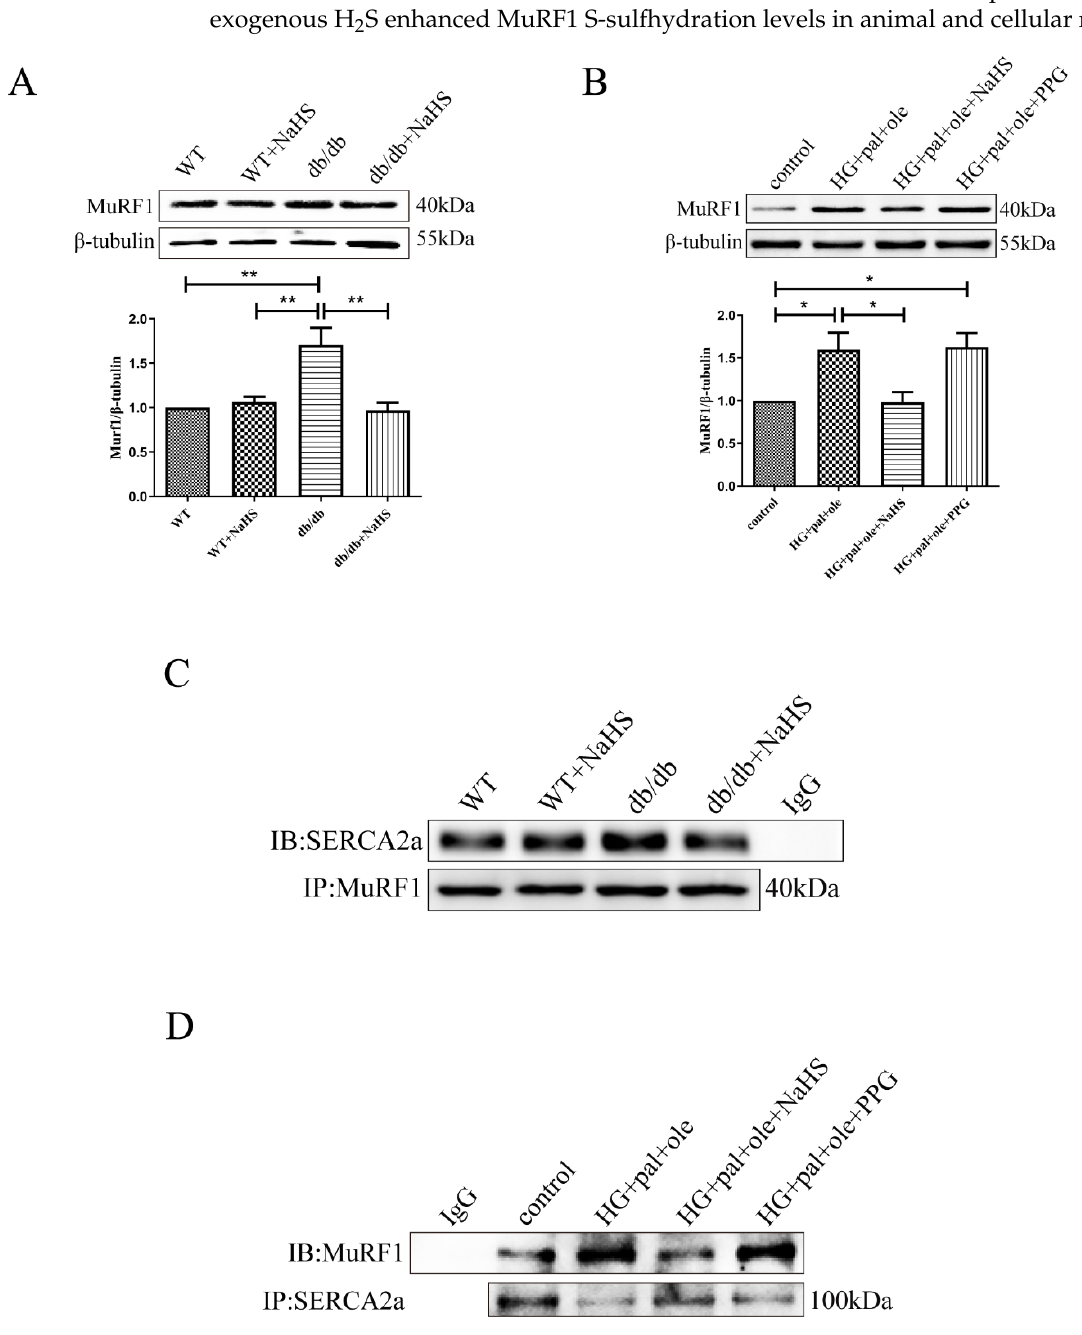
Figure 5. Exogenous H 2 S downregulates the interaction of SERCA2a with MuRF1. ( A ) SERCA2a expression was detected by Western blot analysis in the cardiac tissues ( n = 4). ( B ) SERCA2a expression was detected by Western blot analysis in the NRCMs ( n = 3). ( C ) Cardiac tissue lysate was immunoprecipitated with anti MuRF1 antibody and then immunoblotted with antibodies specific for SERCA2a. ( D ) The NRCMs were immunoprecipitated with an anti-SERCA2a antibody and then immunoblotted with antibodies specific for MuRF1. All values are presented as means ± standard errors, * p < 0.05, ** p < 0.01.